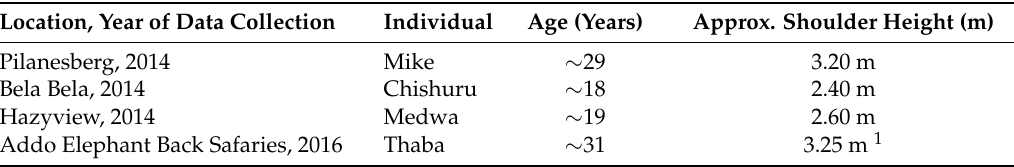
Table 1. Study sites and age for each study